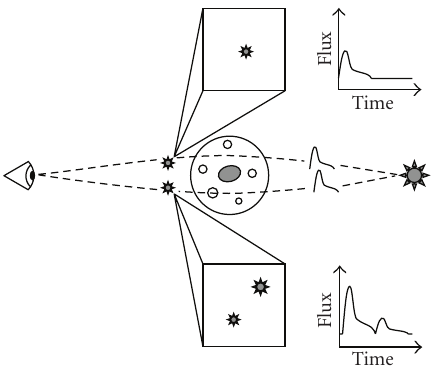
Figure 7: A galaxy with a dark matter halo produces distinct macroimages of a background light source. If this source displays intrinsic variability, observable time delays between the di ff erent macroimages may occur. If one of the macroimages experiences further small-scale image splitting due to a subhalo along the line of sight, a light echo may be observable in the a ff ected macroimage. This may serve as a signature of millilensing in cases where the small-scale images blend into one due to insu ffi cient angular resolution of the